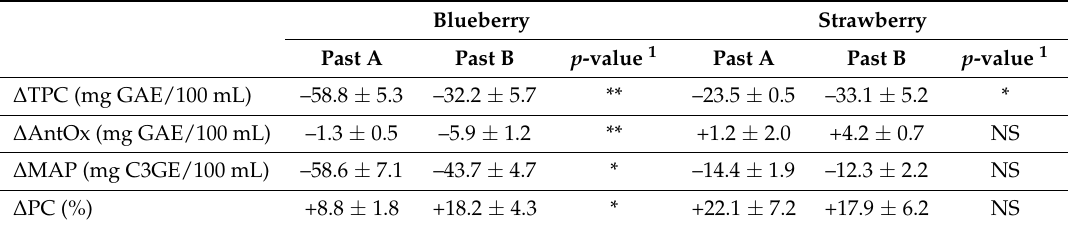
Figure 5. Differences in total phenolic content ( Δ TPC, mg GAE/100 mL) and antioxidant activity ( Δ AntOx, mg GAE/100 mL) occurring with pasteurization in A and B lots of ‘yellow’ fruit ‐ RCW beverages and significance of Student’s t test ( p ‐ value). Bars refer to standard error ( n = 3). 1 Significance of Student’s t testis expressed with asterisks: * p < 0.05, ** p < 0.01 and *** p < 0.001. Table 7. Differences in total phenolic content ( ∆ TPC), antioxidant activity ( ∆ AntOx) total monomeric anthocyanin content ( ∆ MAP) and percent polymeric color ( ∆ PC) occurring with pasteurization in A and B lots of ‘red’fruit ‐ RCW beverages and significance of Student’s t test ( p ‐ value). Blueberry